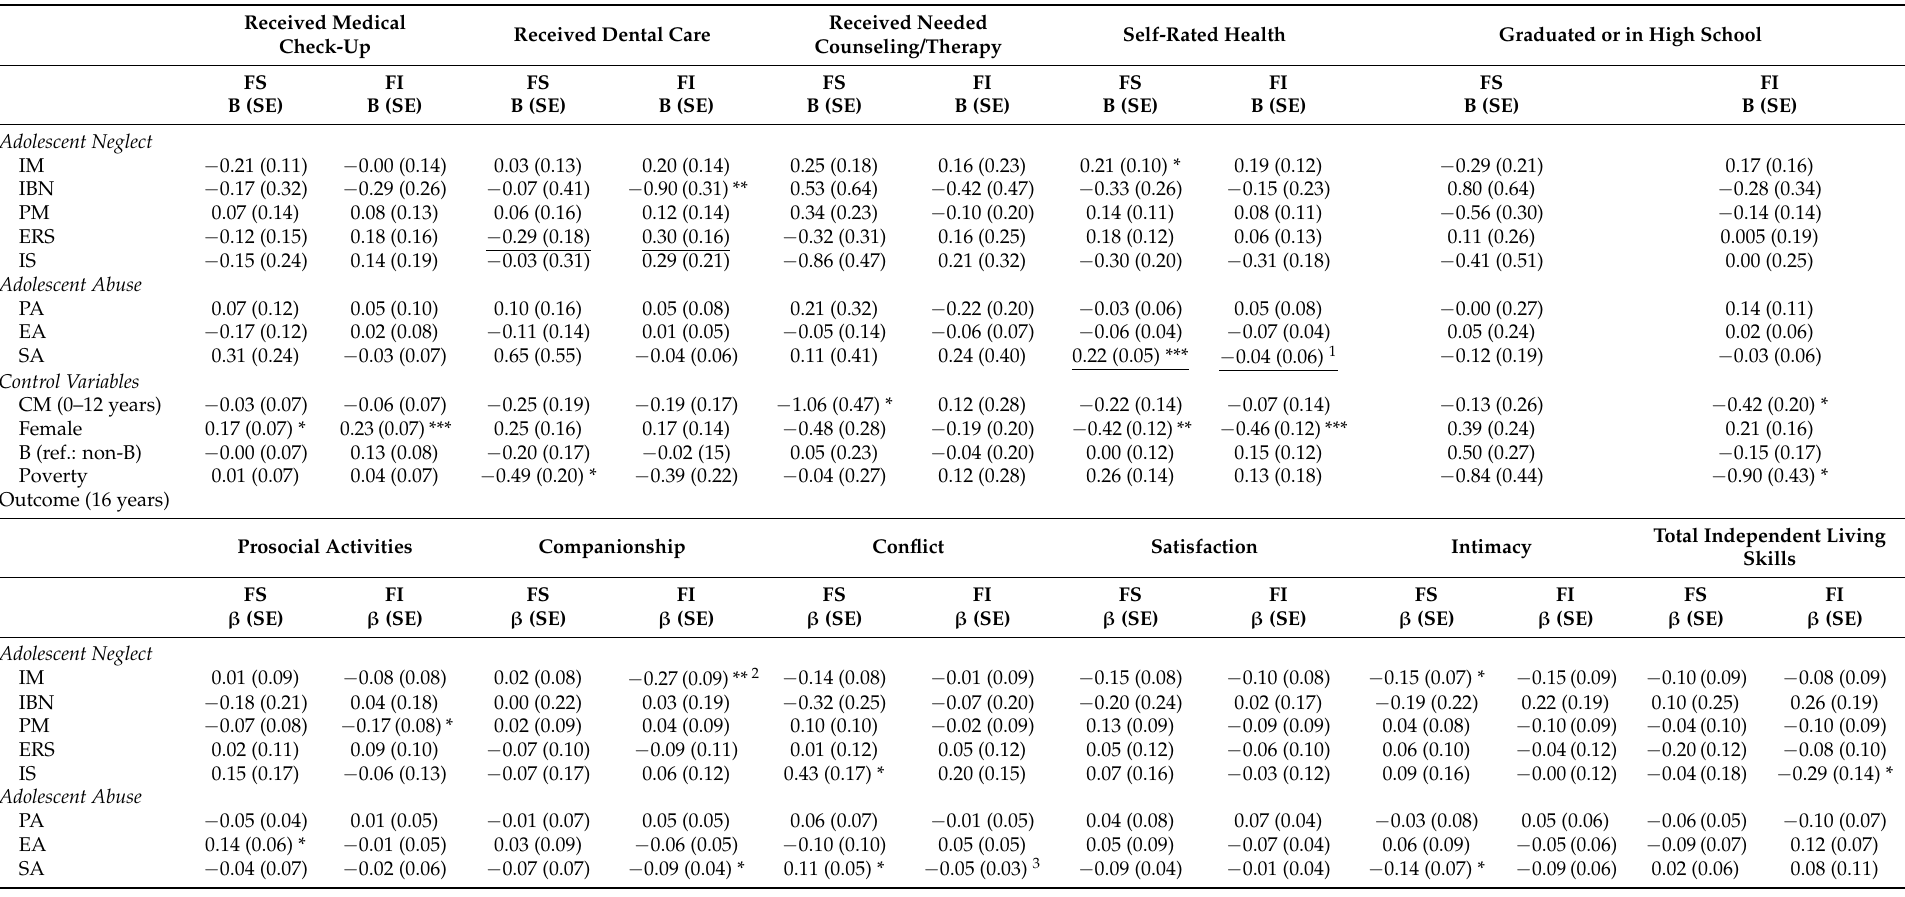
Table 4. Multigroup Structural Equation Models Predicting Functional Adaptations as Moderated by Food Security ( N =